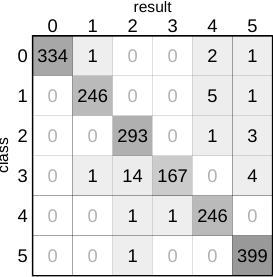
Figure 31. Confusion matrix for the HOG-SVM gesture